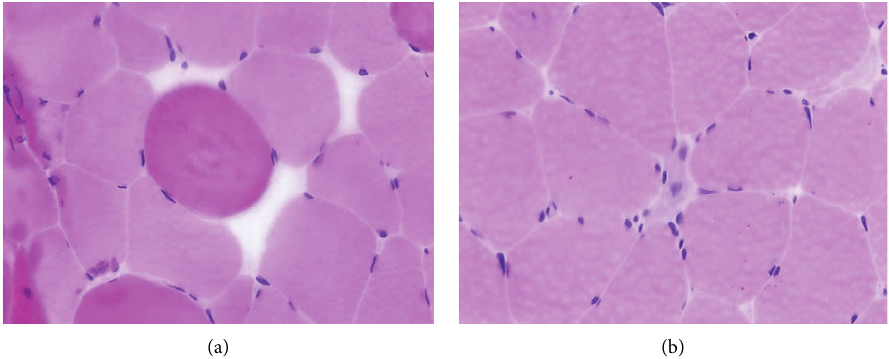
Figure 3: Degenerating (a) and regenerating (b) muscle fibers at 400 x